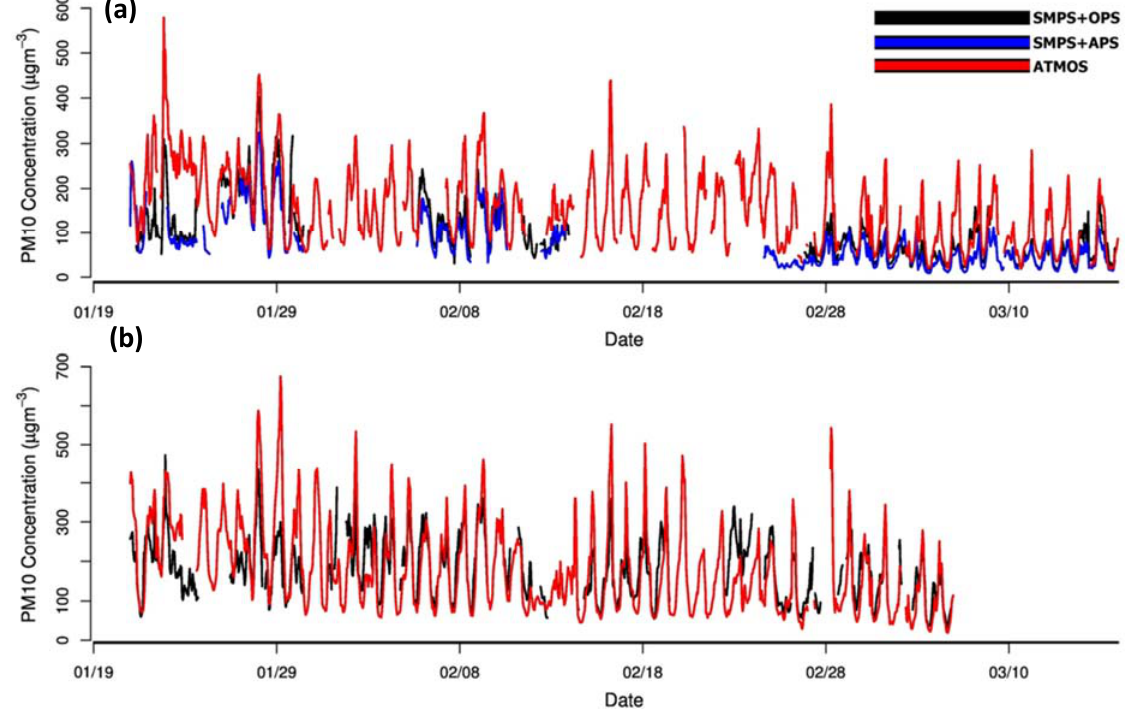
Figure 4. Time series of ambient PM 10 concentrations ( μ g ∙ m − 3 ) data collected from Atmos PMS7003 sensor and reference instruments (merged PM 10 from SMPS-OPS and SMPS–APS) during the deployment period at ( a ) Manav Rachna International Institute of Research and Studies, Faridabad (Delhi-NCR) and ( b ) Indian Institute of Technology Delhi, New Delhi monitoring